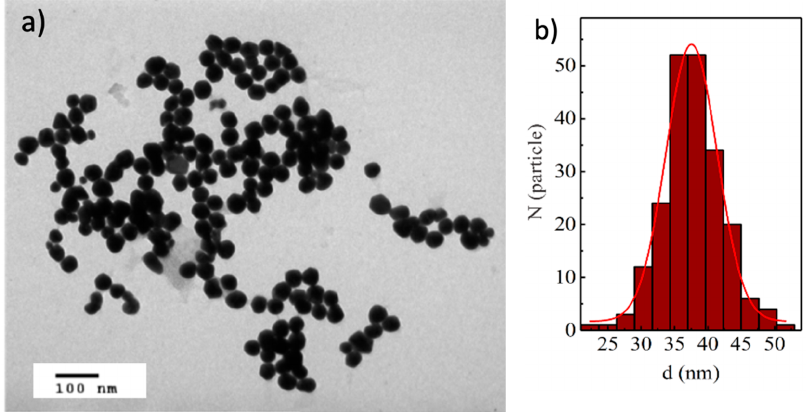
Figure 5. TEM image (a) and particle size distribution histogram (b) of gold nanoparticles (AuNPs) produced by the plasma–liquid interaction method with a precursor concentration of 0.06 mM.